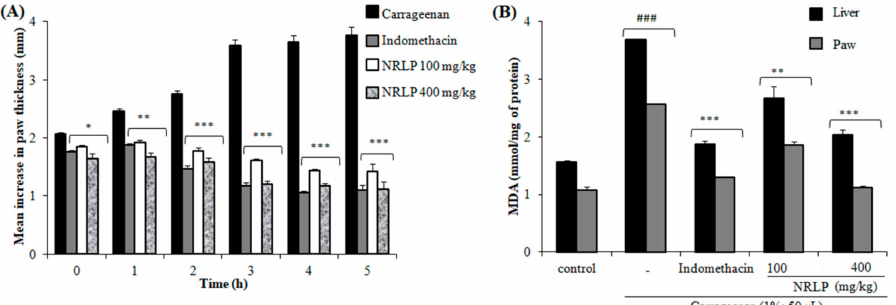
Figure 6. E ff ect of NRLP (100 and 400 mg / kg) and indomethacin (10 mg / kg) on carrageenan-induced mice paw edema ( A ) and MDA concentrations in paw edema and liver ( B ). Each column represents mean ± SD of six mice per group. ### p < 0.001 compared with the control group. * p < 0.05, ** p < 0.01 and *** p < 0.001 compared with the carrageenan